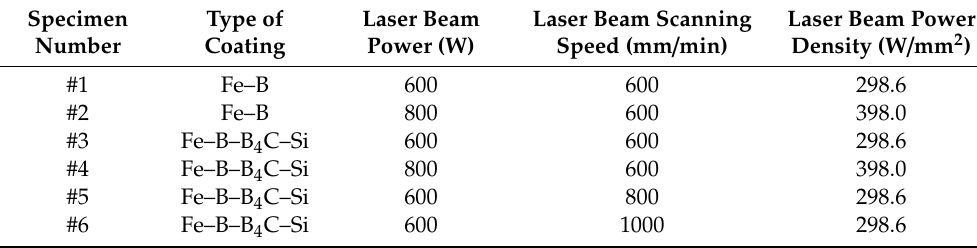
Figure 2. Scheme of: ( a ) producing Fe–B–B 4 C–Si composite coatings using laser cladding process; ( b ) Marangoni convection—phenomenon causing the mixing of the substrate components with the coating components. Table 2. Parameters of laser cladding process.